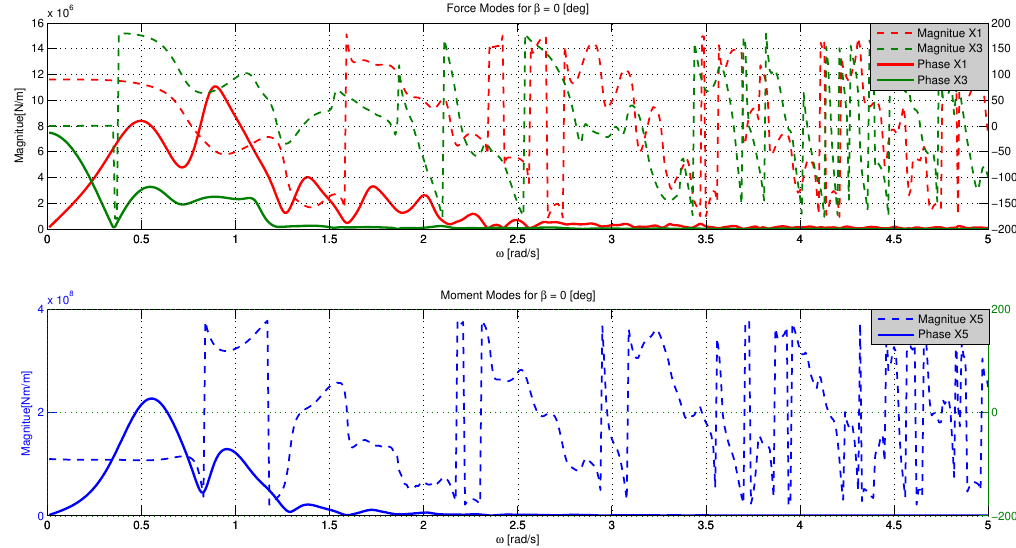
Figure 10. SNL semi-submersible platform excitation force coefficients for a zero wave